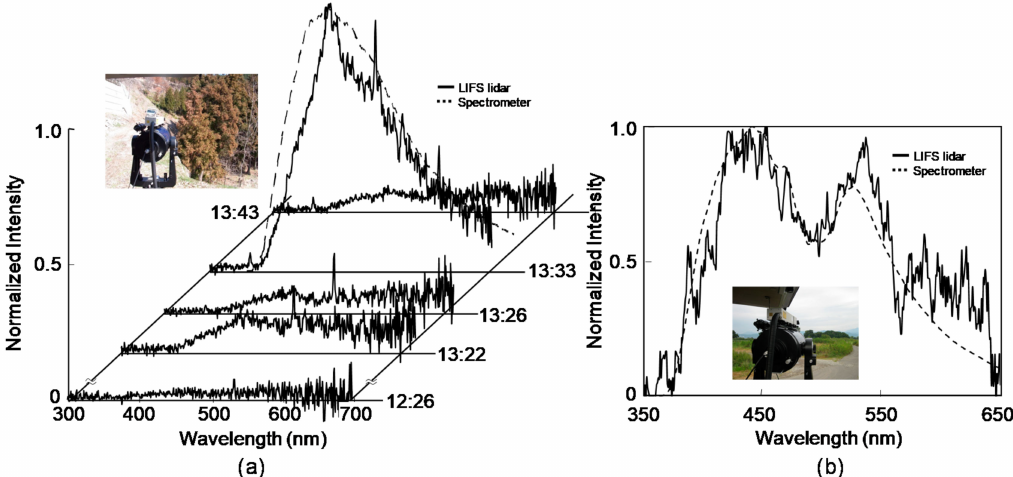
Figure 5. Detection of fluorescence spectrum of Jpn. Cedar pollen ( a ) and Ragweed pollen ( b ) in the air by the LIFS